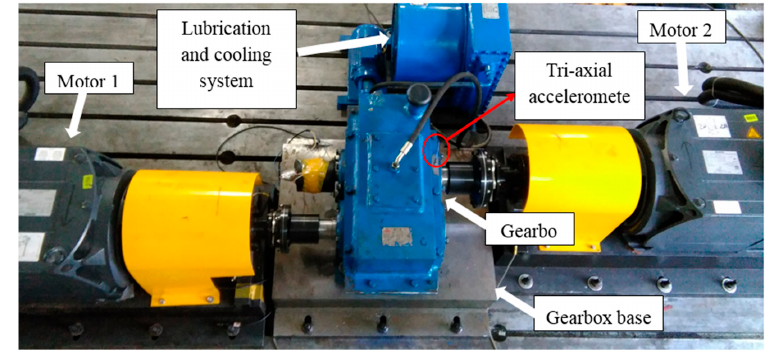
Figure 5. The gearbox test rig.